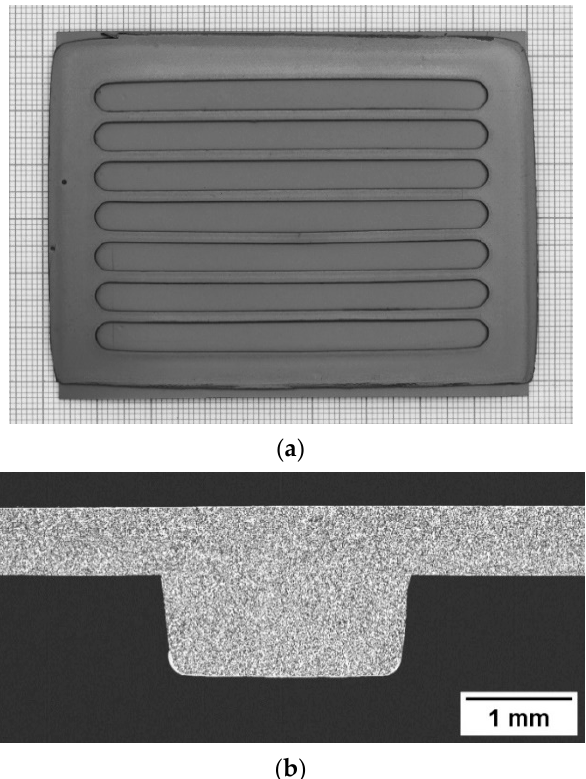
Figure 5. ( a ) Sintered half-component obtained by lamination of an asymmetric membrane and a channeled interlayer. ( b ) SEM cross section of a stability element.